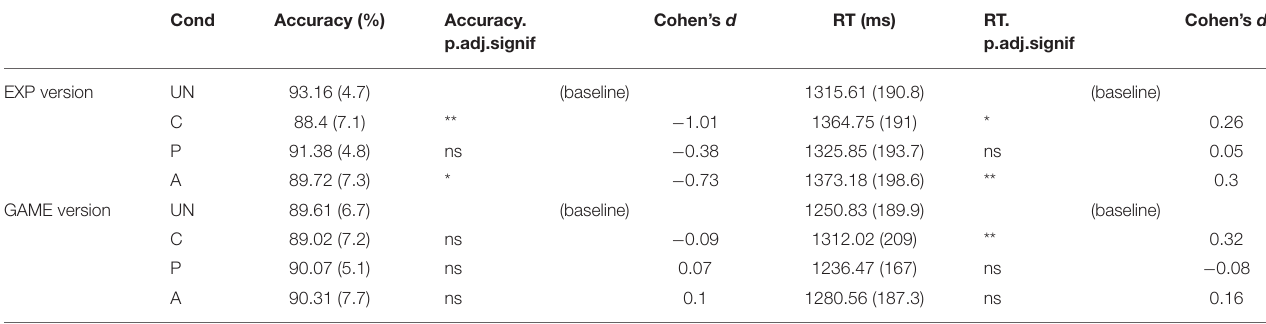
TABLE 1 | Experiment 1: Accuracy (%) and RT (ms) are shown as mean (s.d.).